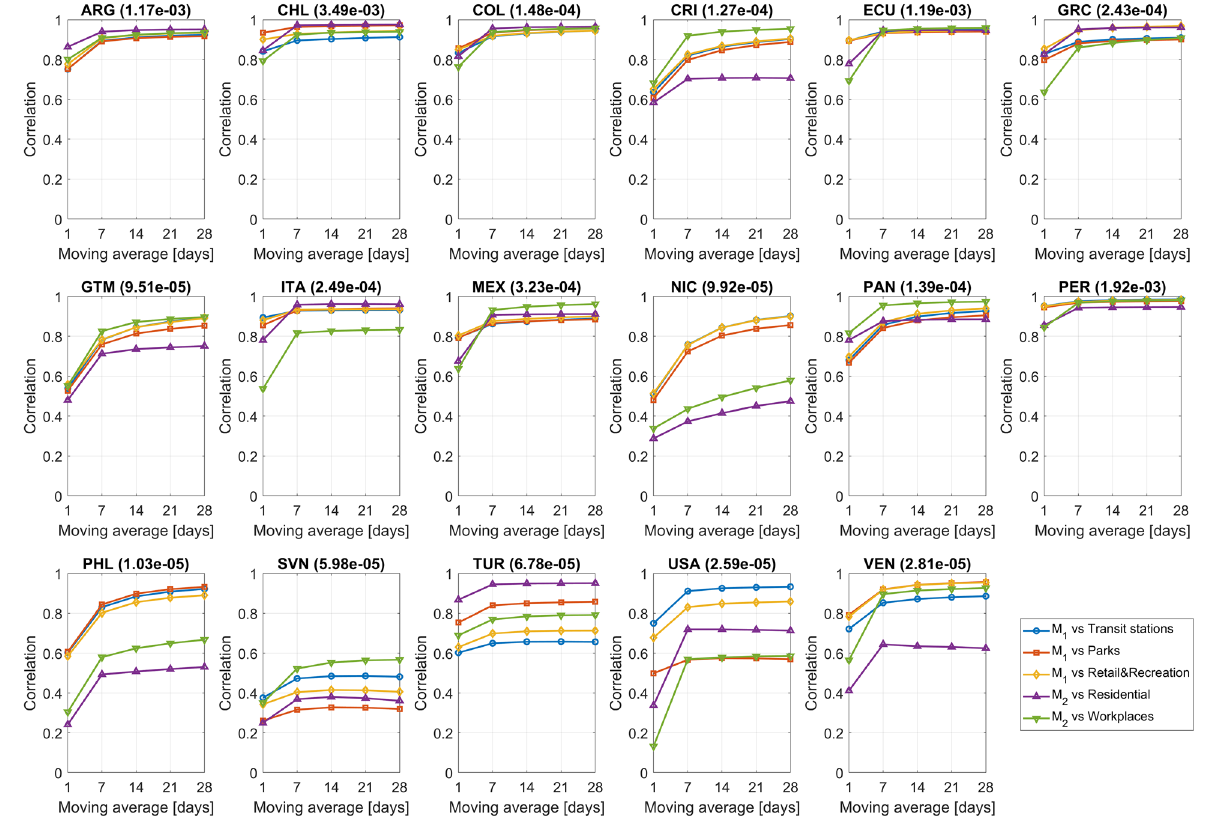
Figure 3. Linear correlation between the M 1 mobility metric and Google’s “Transit stations” index, between M 1 and Google’s “Parks” index, between M 1 and Google’s “Retail and Recreation” index, between the M 2 mobility metric and Google’s “Residential” index and between the M 2 and Google’s “Workplaces” index. 1-day moving average means no smoothing. All correlations between M 2 and Google’s “Workplaces” index are negative